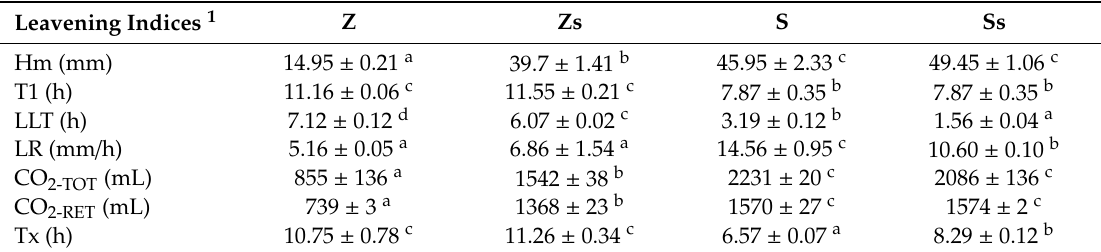
Table 3. Dough leavening properties (mean ± standard deviation values of two technological replicates) of samples leavened for 24 h at 26 ◦ C by Z. mobilis (Z) or S. cerevisiae (S) with or without sucrose (s) addition. See Table 1 for sample identifications and